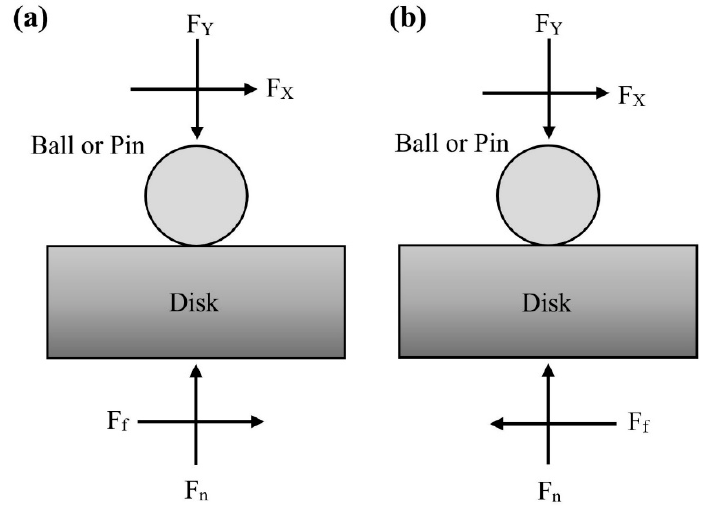
Figure 14. Schematic representation of a common friction coefficient measurement: ( a ) forward and ( b ) reverse sliding.